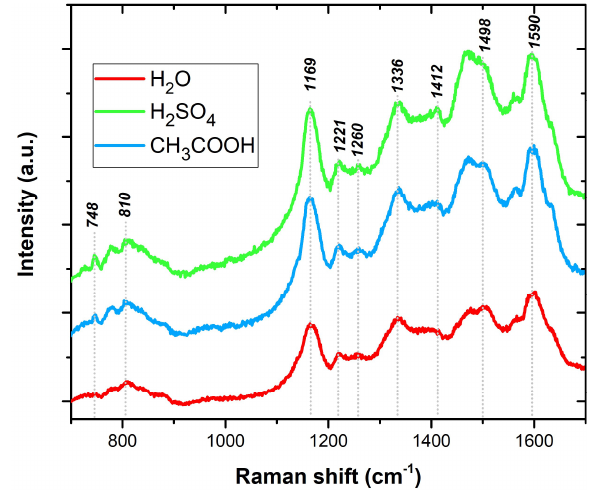
Figure 7. The Raman spectra of the PANI layers.